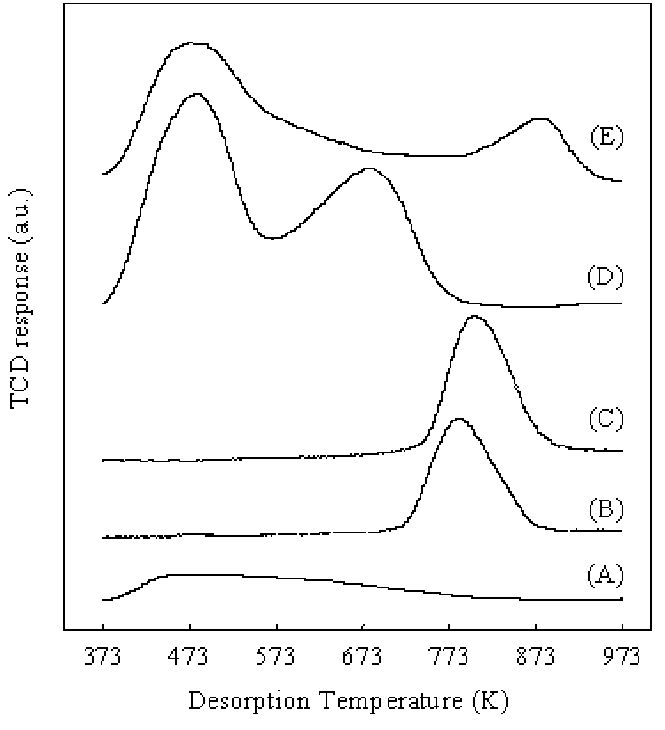
-TPD profiles of various catalysts. (A): Pt/Al Figure 8. NH 3 Pt/Al O +Cs2.5; (D): Pt/Al 2 3